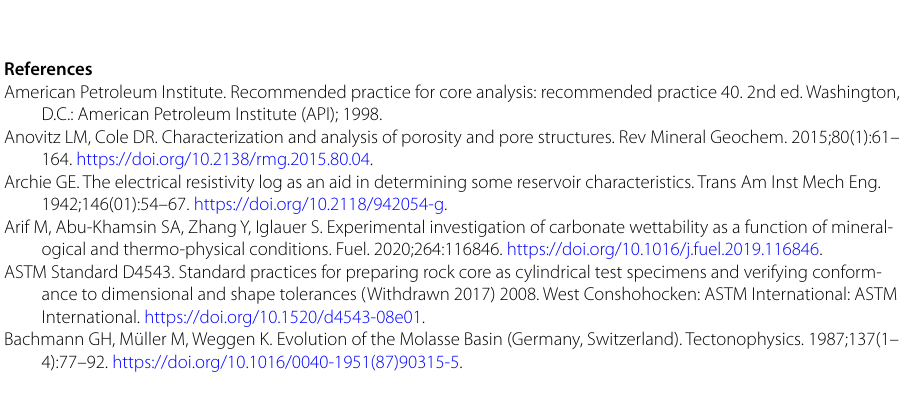
Min minimum, Max maximum, Med median, MAD median absolute deviation, n count)